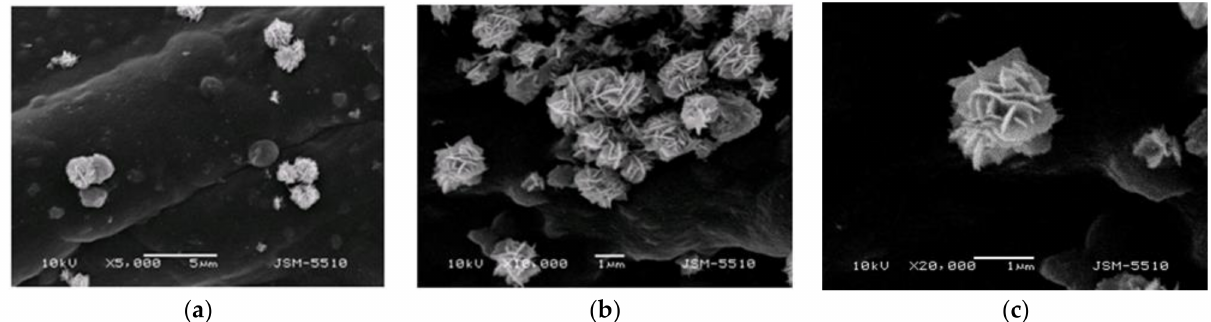
Figure 4. SEM images of zinc oxide particles structure and their distribution in composite material ChZn at different magnification ( a ) × 5000, ( b ) × 10,000; ( c ) ×